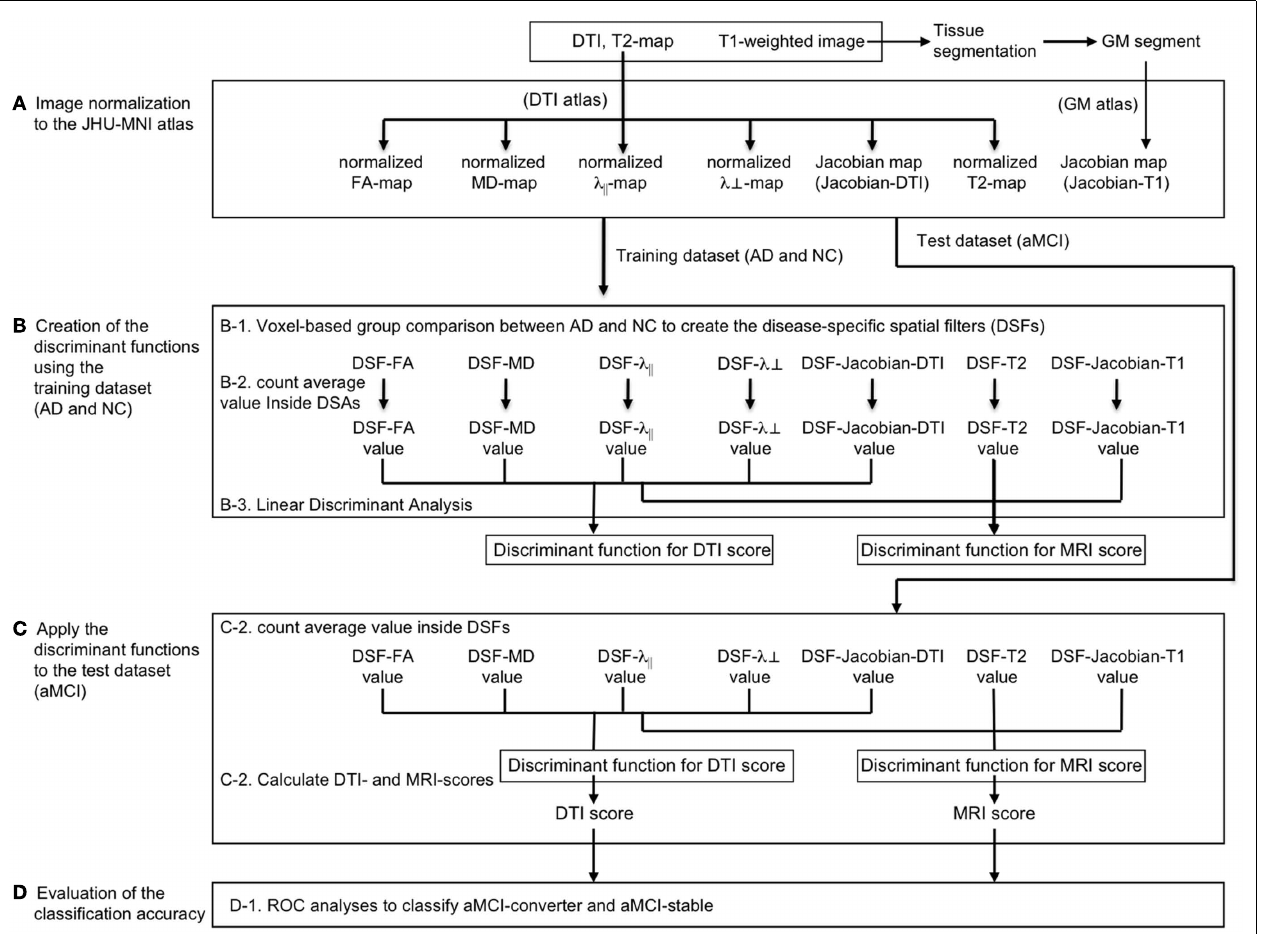
FIGURE 1 | Flow chart of the